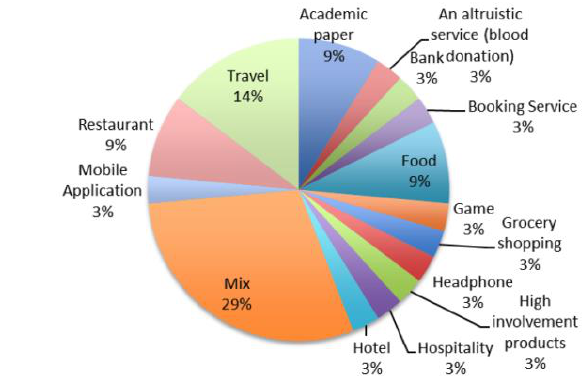
Figure 4: Distribution of studies based on industry fields